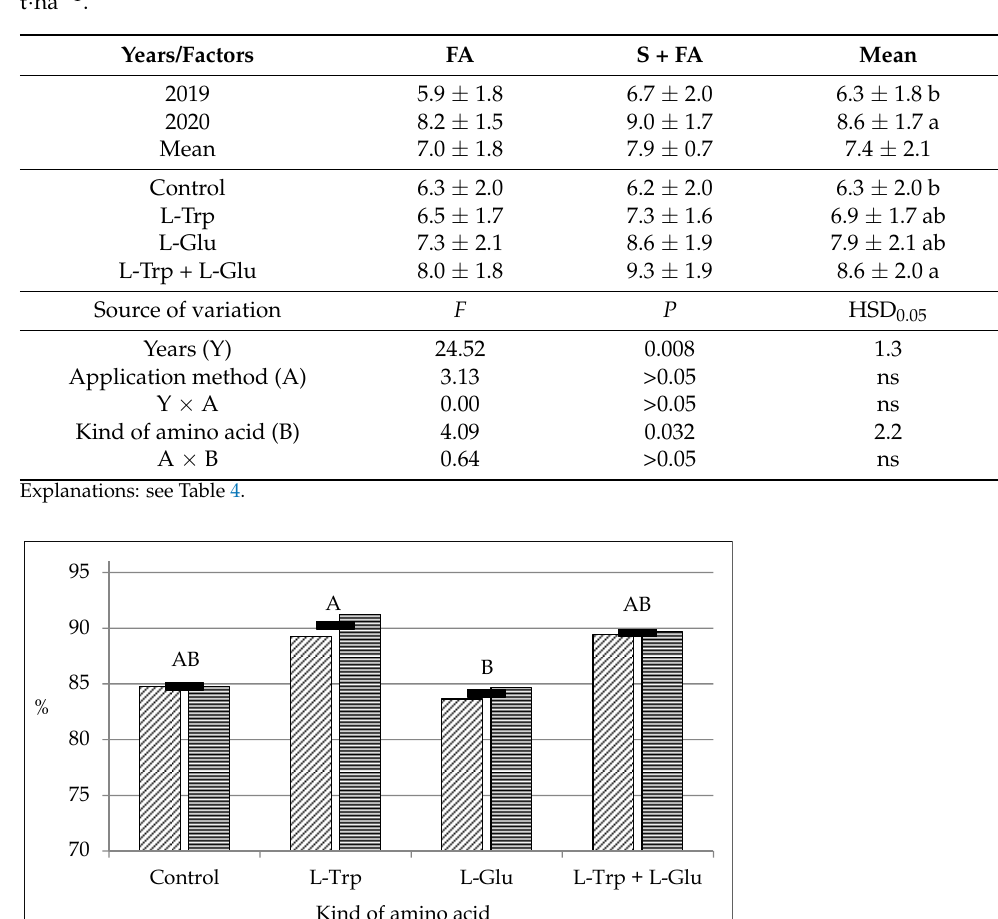
Table 5. Effects of research factors and years on the mass of aboveground parts of carrot (leaves); t · ha − 1 .